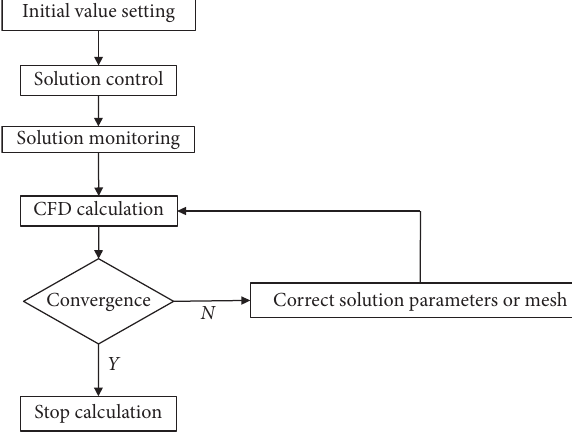
Figure 2: FLUENT solution process block diagram.